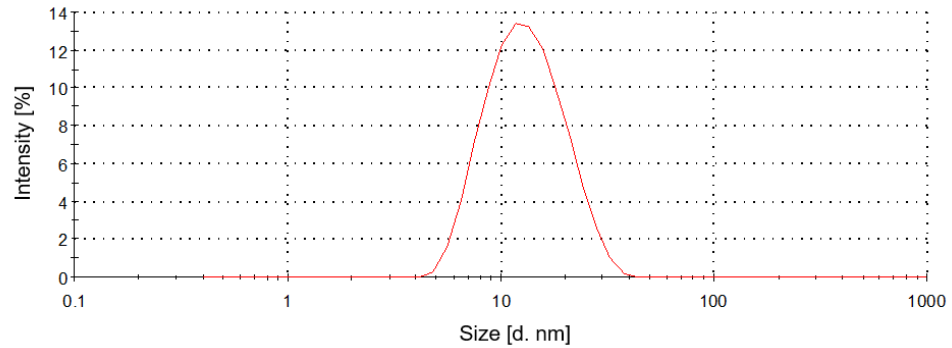
Figure 2. Particle size distribution curves of the extraction medium.